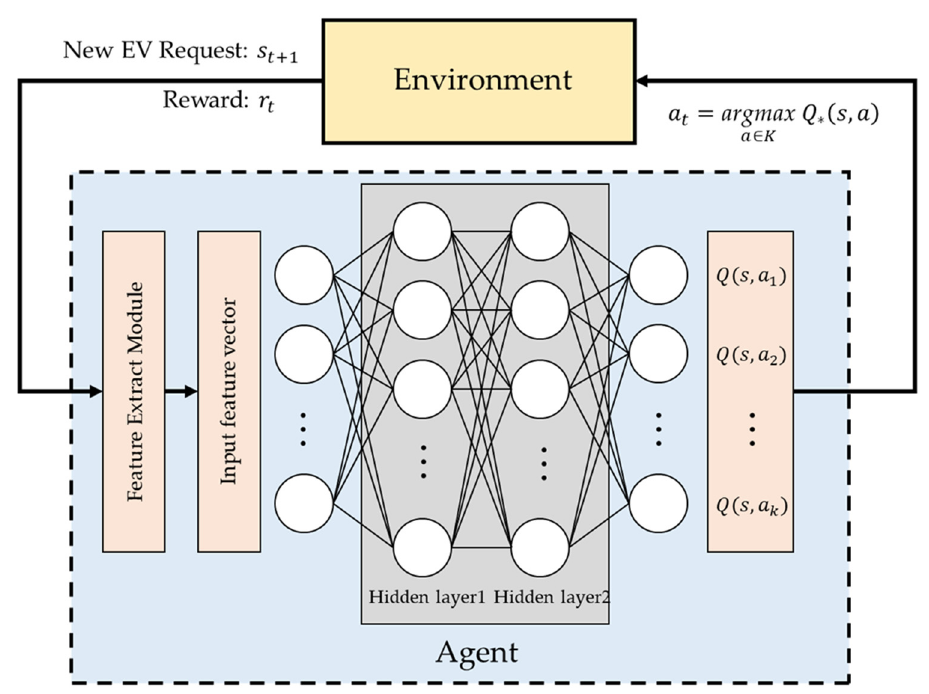
Figure 4. Overview of training process.